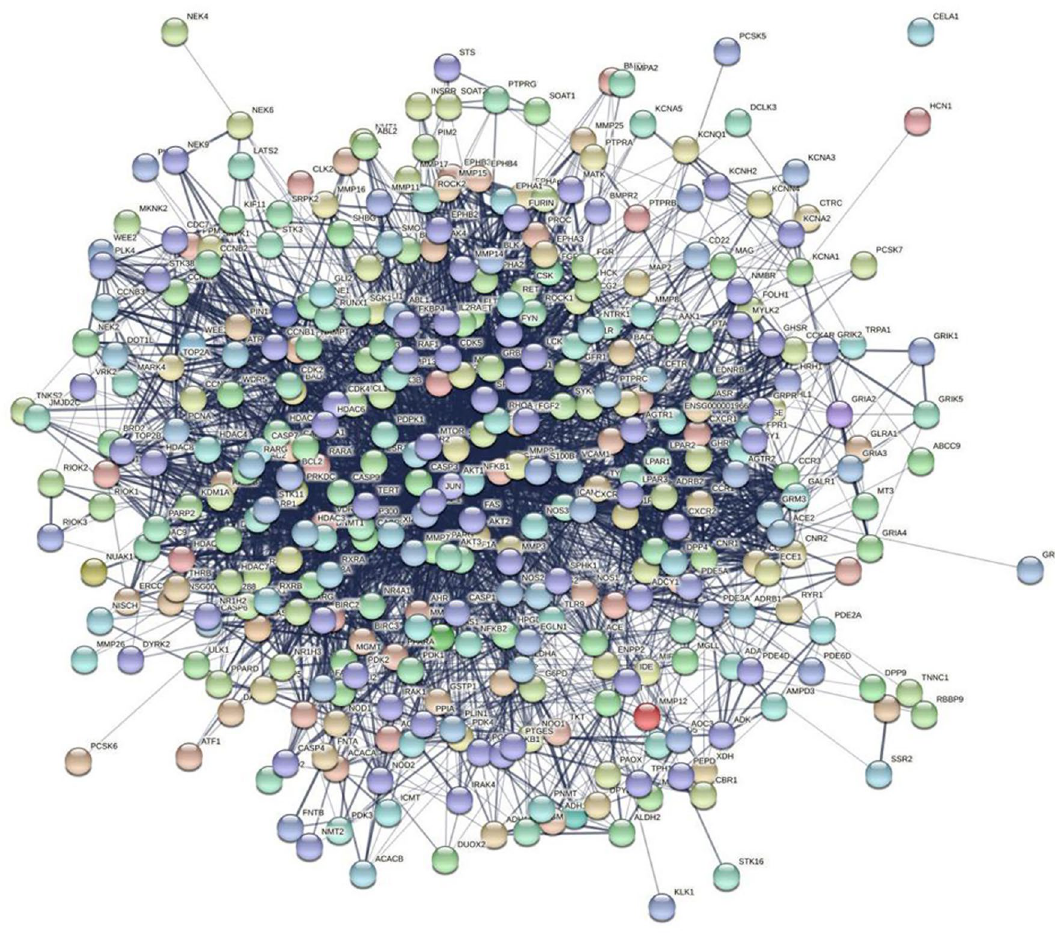
Figure 3. PPI network diagram of targets of WFEA against lung